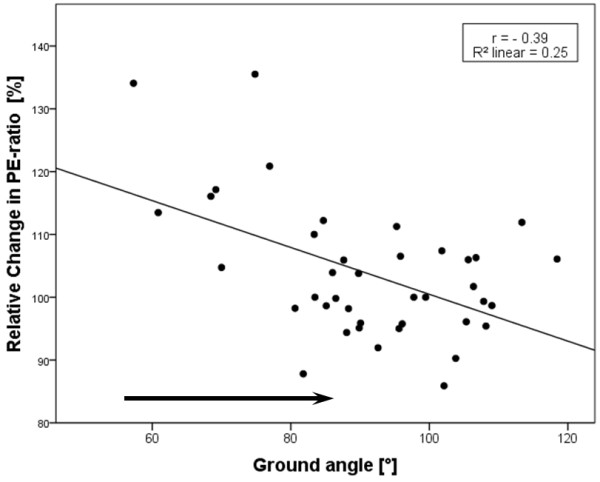
Correlation between the GA and the relative change in PE-ratio. The arrow (above the x-axis) points in the direction of increasing head-neck flexion (n = 40).